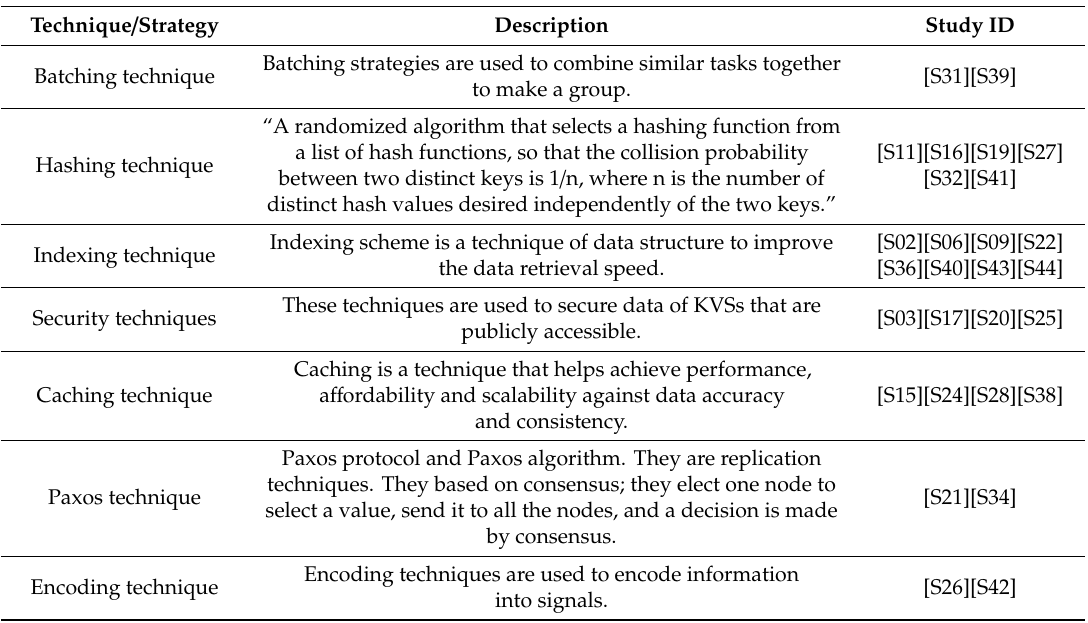
Table 6. List and description of execution techniques.